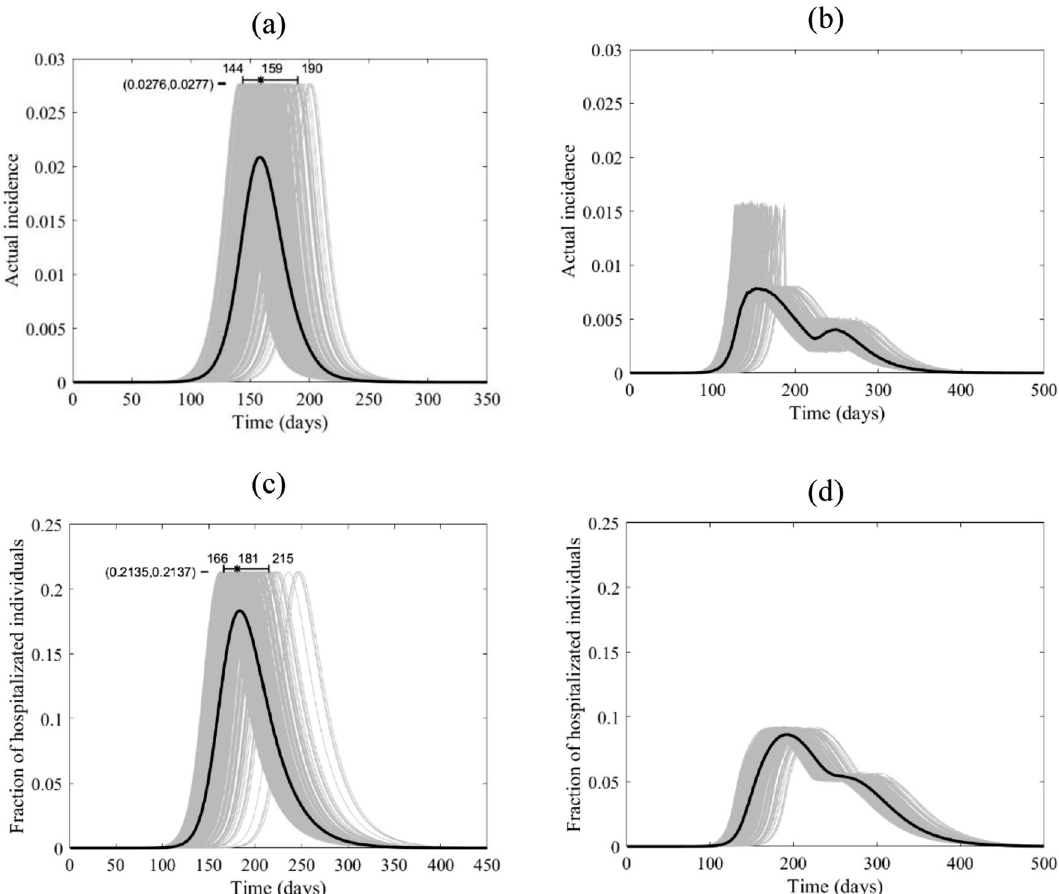
Figure 7. The course of the actual incidence ( a ) and ( b ), and fraction of hospitalized COVID-19 infected individuals ( c ) and ( d ) in Mexico with no control measure (left panel) and with starting lockdown (right panel) of 15 days before the peak and that lasts for 90 days. They are calculated at R 0 = 6.47 , with initially one adult mild infection. The grey curves are resulting from the stochastic model simulations and the black curve is the mean of those grey curves. They are all normalized by the population